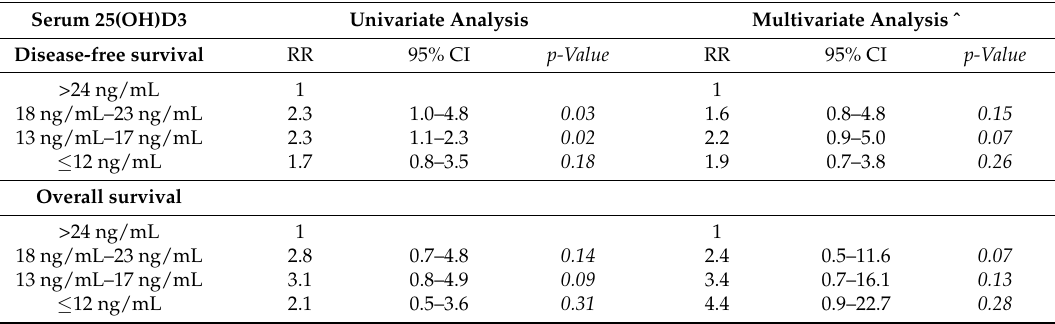
Table 7. Cox regression analysis for relative risk of disease-free and overall